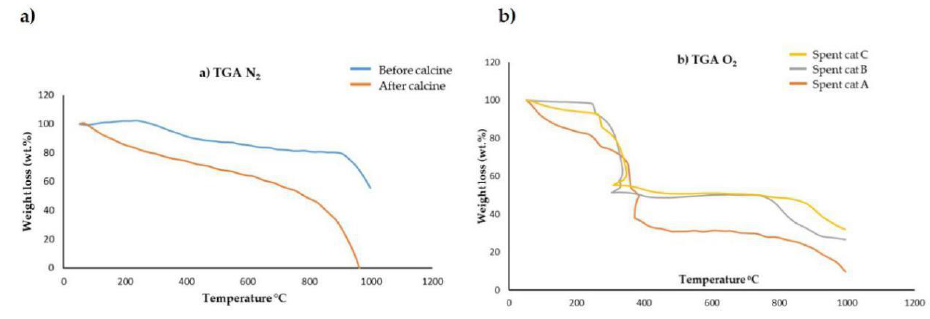
Figure 5. TGA profile for ( a ) before and after catalyst calcination in N 2 and ( b ) spent catalyst sample A, B, C using O 2 .